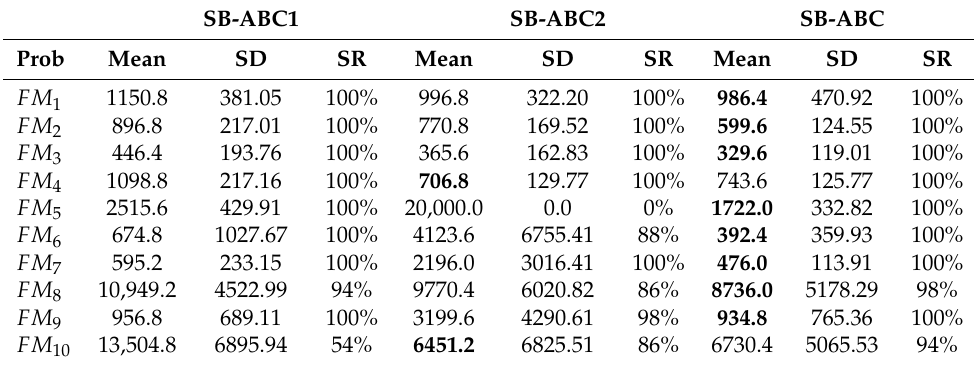
Table 9. Comparison results of the SB-ABC1, SB-ABC2 and SB-ABC for the FM 1 – FM 10 minimax